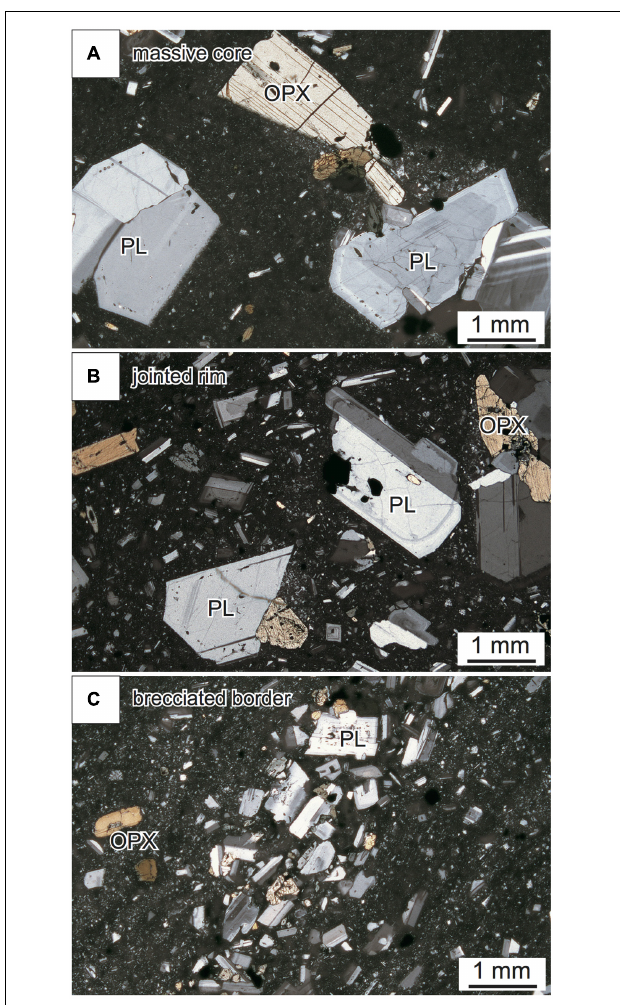
FIGURE 8 | Photomicrograph of rhyodacites from the (A) massive core, (B) jointed rim, and (C) brecciated border (cross-polarized light). Note that a phenocryst-rich zone occurs in the brecciated border. PL, plagioclase; OPX, orthopyroxene.